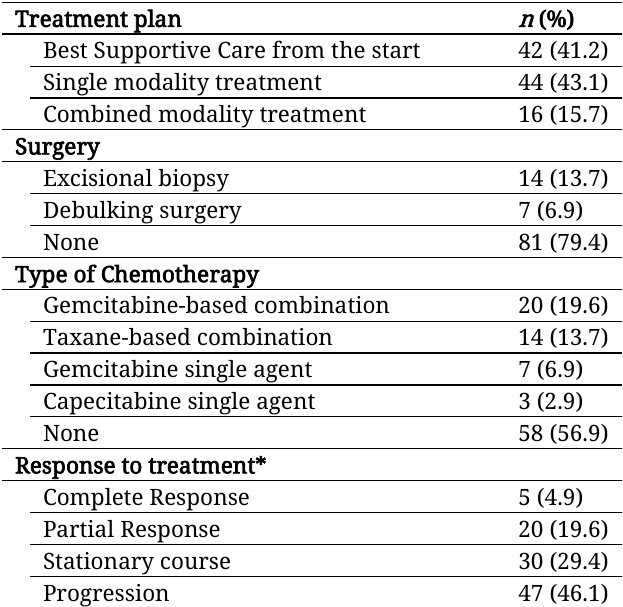
Table 2: Treatment modalities and response Treatment